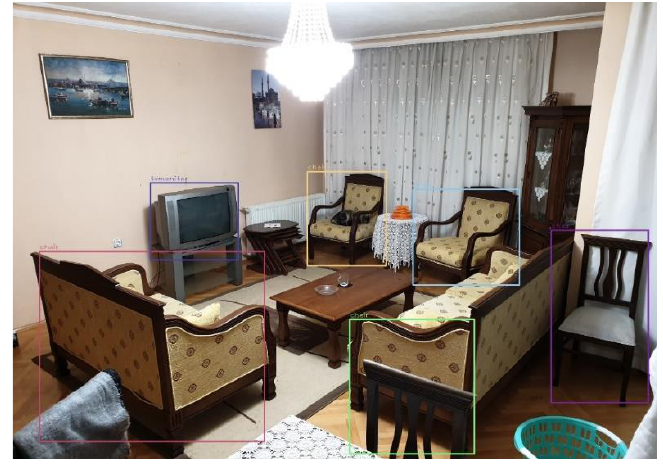
Fig. 18. Objects recognized with YOLOv3 architecture in the living